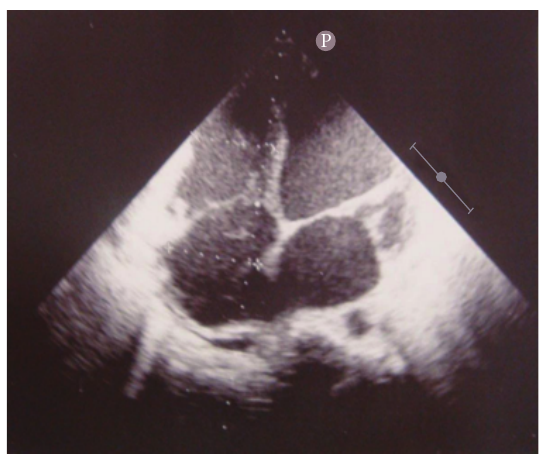
Figure 1: Cardiac echogram (apical view) showing severe dilation of 4